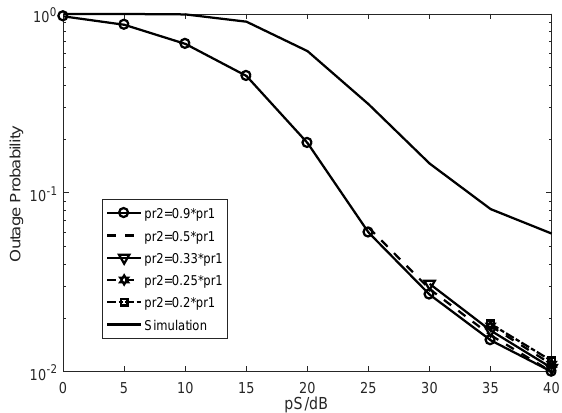
Figure 7. Outage probability of HHWN with MMR as different relay power p r 2 equals 9/10,1/2,1/3,1/4,1/5 times p r 1 .